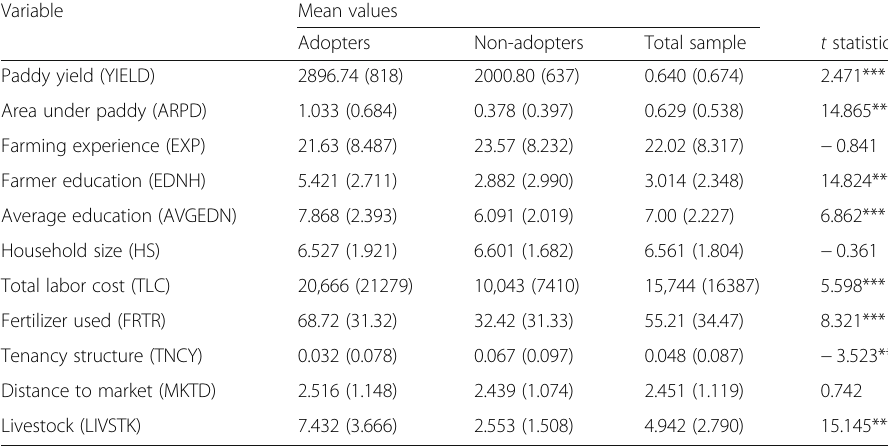
Table 2 Descriptive statistics and mean differences of continuous variables Variable Mean values Adopters Non-adopters Total sample t statistic Paddy yield